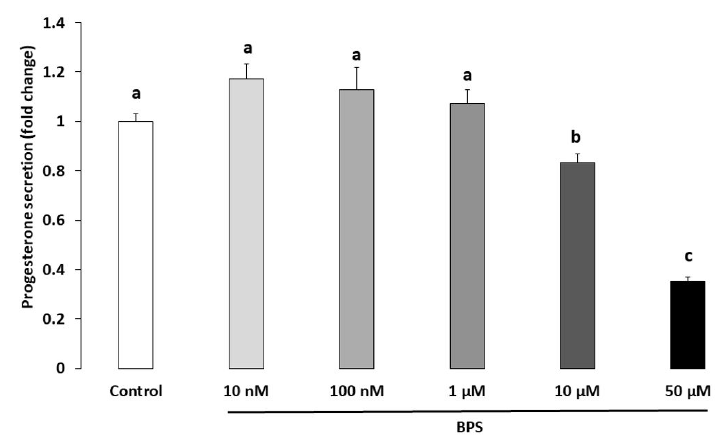
Figure 3. E ff ect of Bisphenol S (BPS) on human granulosa cell (HGC) progesterone secretion. HGC underwent 48-h culture in the presence or absence of BPS (10 nM, 100 nM, 1 µ M, 10 µ M or 50 µ M). The progesterone concentration was measured in culture media, and its value was normalised by the protein concentration in each well. Data are expressed as ng progesterone per µ g protein and normalised to the control condition. The results of seven independent experiments are presented as the mean ± standard error of the mean (SEM). Bars with di ff erent superscripts indicate a significant di ff erence ( p ≤ 0.05).